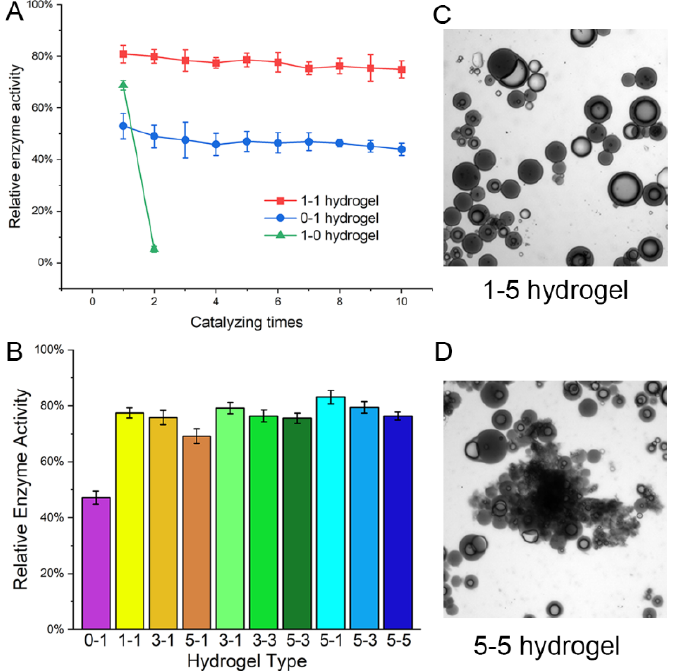
Figure 2. Relative enzyme activities and images of hydrogels with different cross-linking times. ( A ) Dac activities of “1-1”, “0-1”, and “1-0” hydrogels with 10 rounds of catalyzing. The numbers represent the “soft cross-linking” (the previous number) and “hard cross-linking” (the latter number) days of hydrogel. ( B ) Average Dac activities of 10 different kinds of hydrogels. The catalytic activity of free Dac was considered as 100% relative enzyme activity. ( C , D ) Images of “1-5” ( C ) and “5-5” ( D ) hydrogels under microscope. Scale bars are 100 µm.